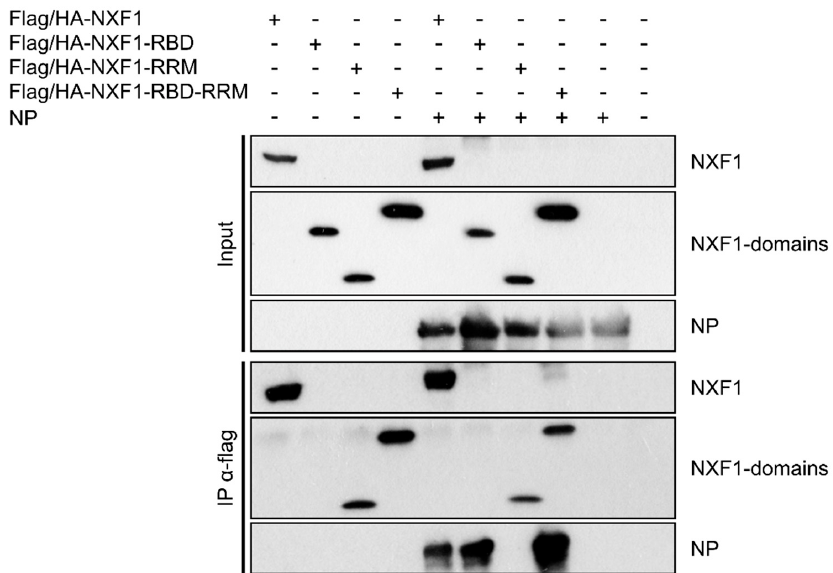
Figure 4. Role of the RNA-binding domain (RBD) and RNA recognition motif (RRM) in the interaction between NXF1 and NP. Immunoprecipitations of lysates from 293T cells transfected with flag/HA tagged NXF1, NXF1-RBD, NXF1-RRM or NXF1-RBD-RRM together with NP using anti-flag antibodies were performed 48 h p.t. Input and precipitate samples were subjected to SDS-PAGE and Western blot, and NXF1 and NP were detected using anti-flag and anti-NP antibodies,